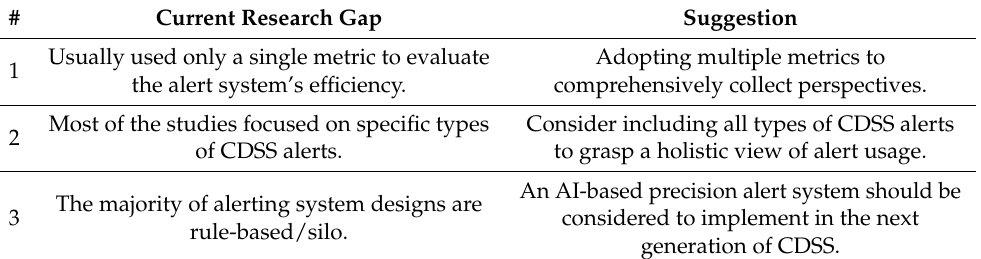
Table 3. The summary of current research gaps and